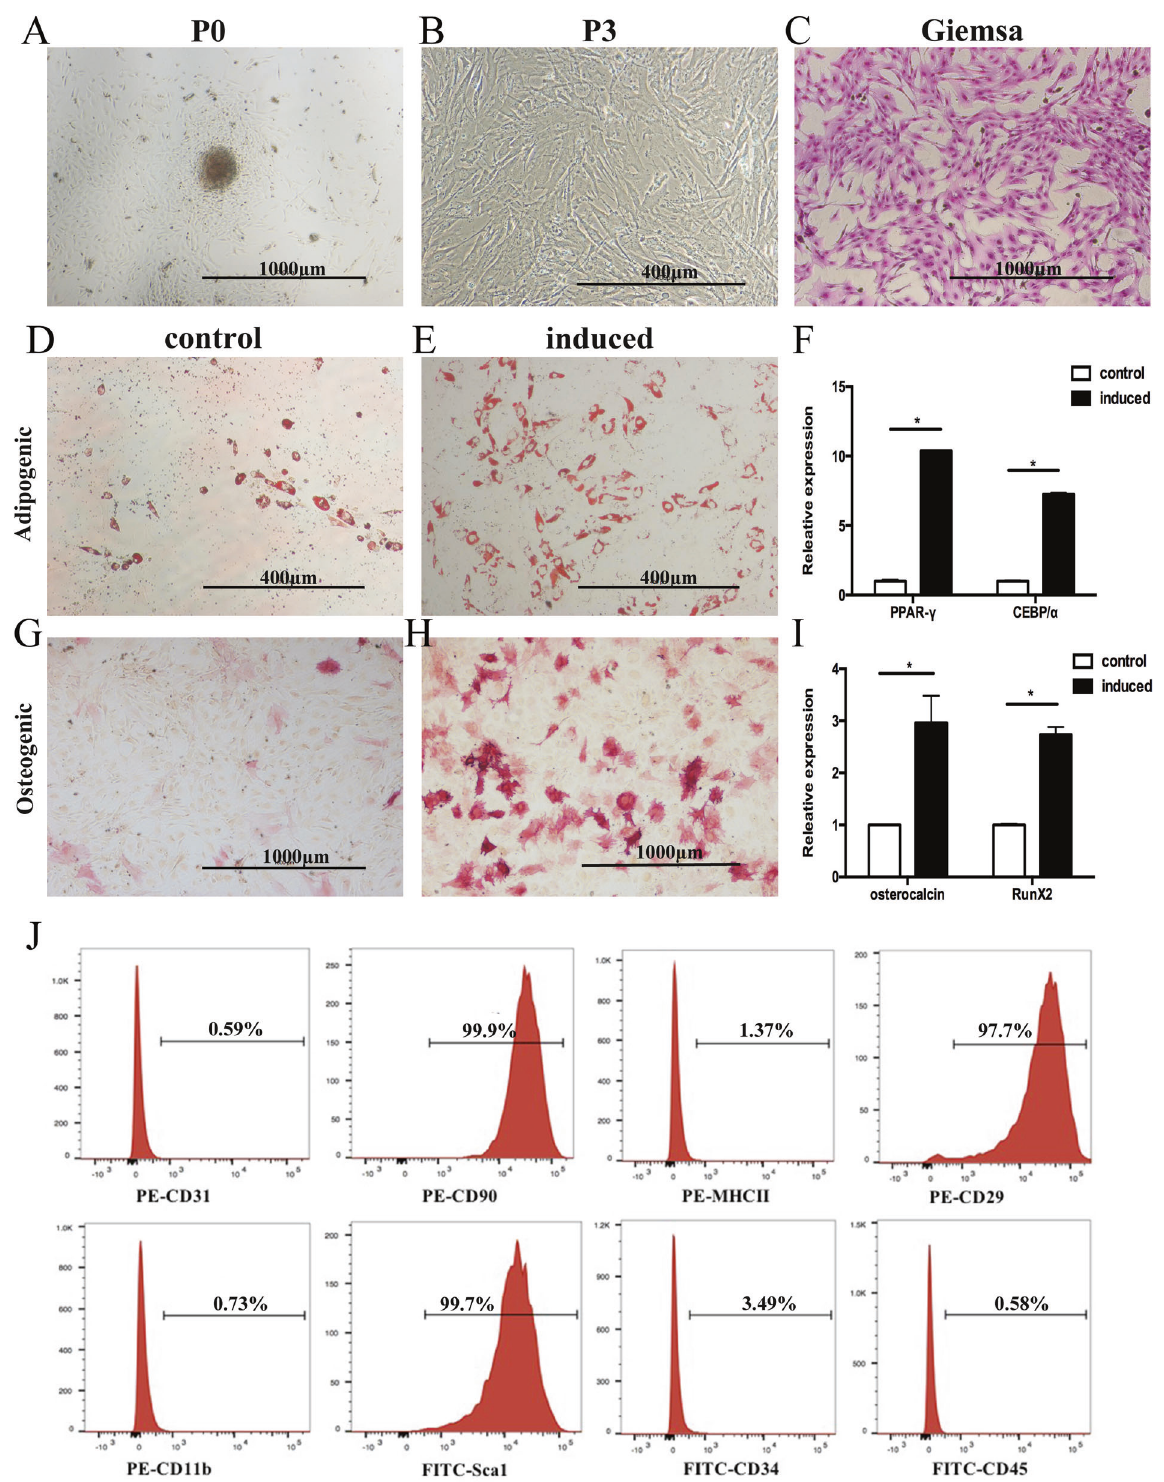
Fig. 1 Isolation and identi fi cation of Wip1 − / − MSCs from murine compact bones. A Nucleated cells isolated from compact bones of Wip1 − / − mice became adherent 72 h after seeding. B The adherent cells (P3) displayed fi broblast-like morphology. The adherent cells were stained with Wright-Giemsa. C Multilineage differentiation potential of compact bone-derived adherent cells in Wip1 − / − mice was assessed by inducing adipogenic or osteogenic capacities in vitro. D , E Adipogenesis differentiation was indicated by the presence of lipid drops stained with oil red O. G , H Osteogenic differentiation was shown by the intracytoplasmic accumulation of alkaline phosphatase. F , I The expression of PPAR- γ and CEBP ɑ in the adipogenic induction group and Osteocalcin and Runx 2 in the osteogenic induction group was detected by qPCR ( n = 3). J Immunophenotyping of culture-expanded adherent cells from Wip1 − / − mice compact bones-derived adherent cells were analyzed by fl ow cytometry. * P < 0.05, compared with control group.